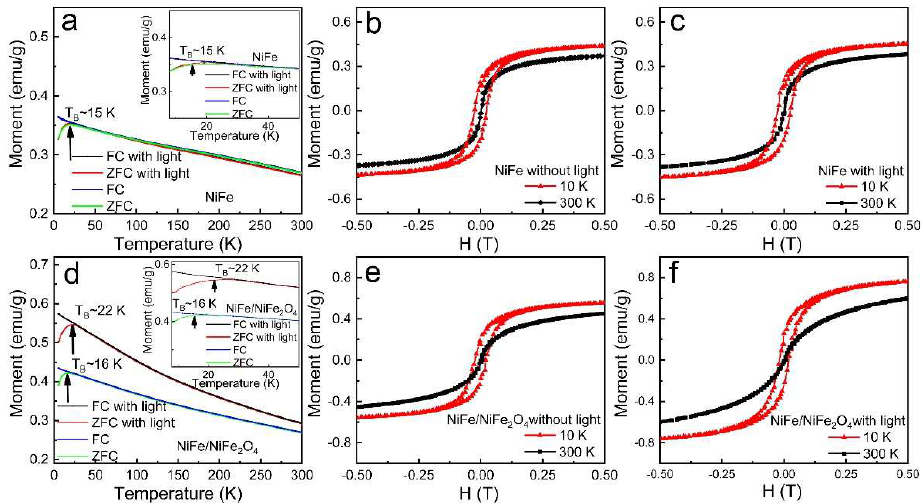
Figure 3. M−T curves ( a , d ), M−H curves ( b , c , e , f ) for NiFe nanoparticles and NiFe/NiFe 2 O 4 core/shell nanoparticles with and without light, respectively. Inset of ( a , d ): corresponding magnified images of M-T curve at low-temperature range.